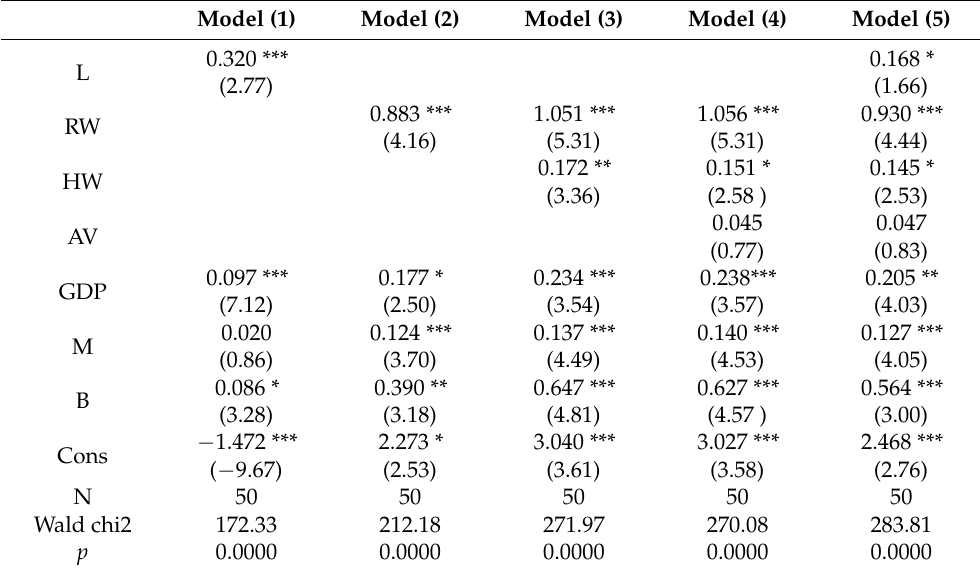
Table 5. Model regression